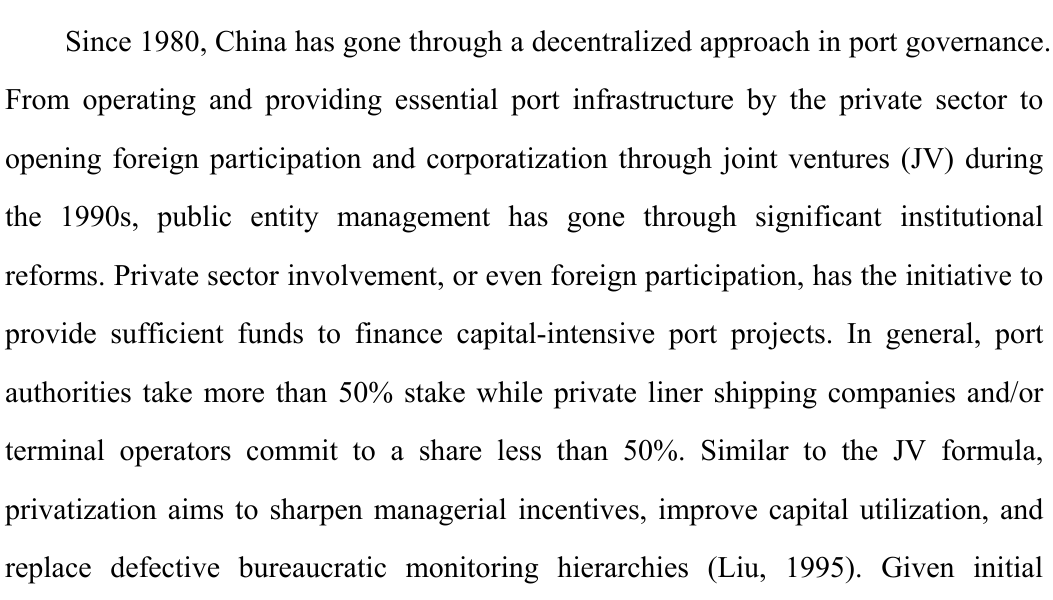
Source: China Shipping Year